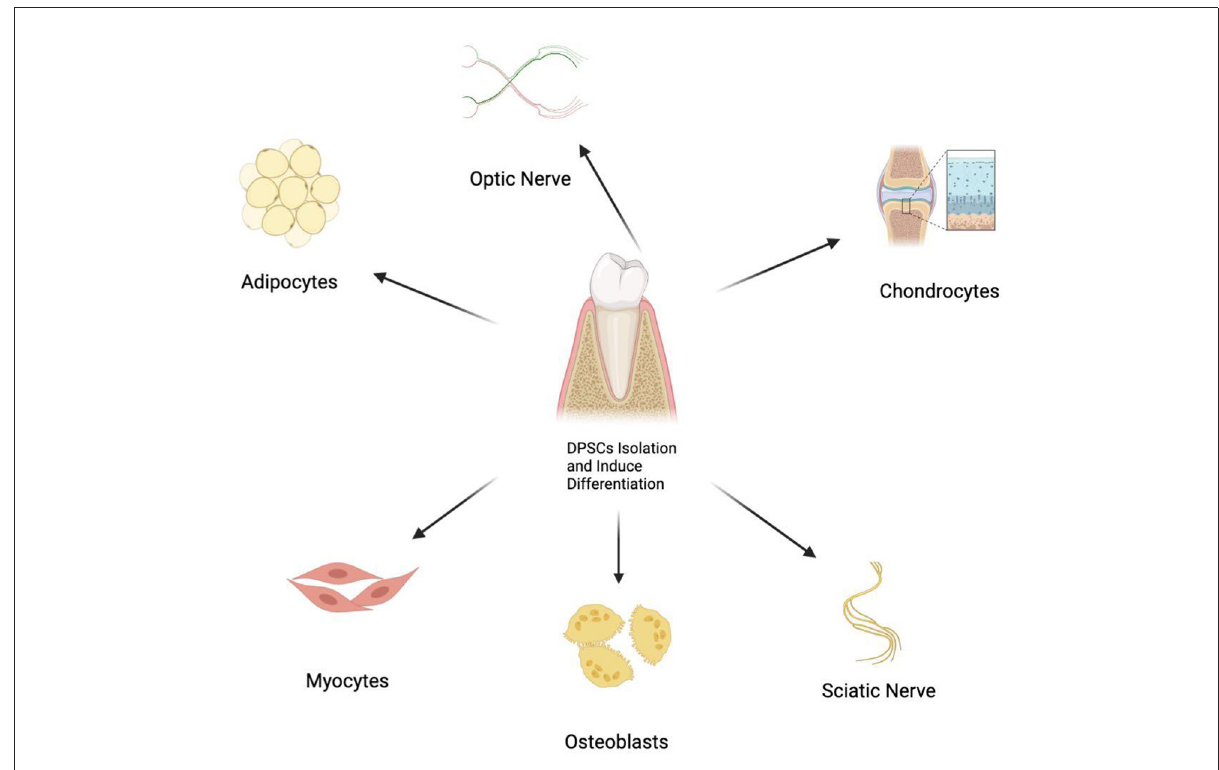
FIGURE1 Multiple differentiation potential of DPSCs into various cell types.